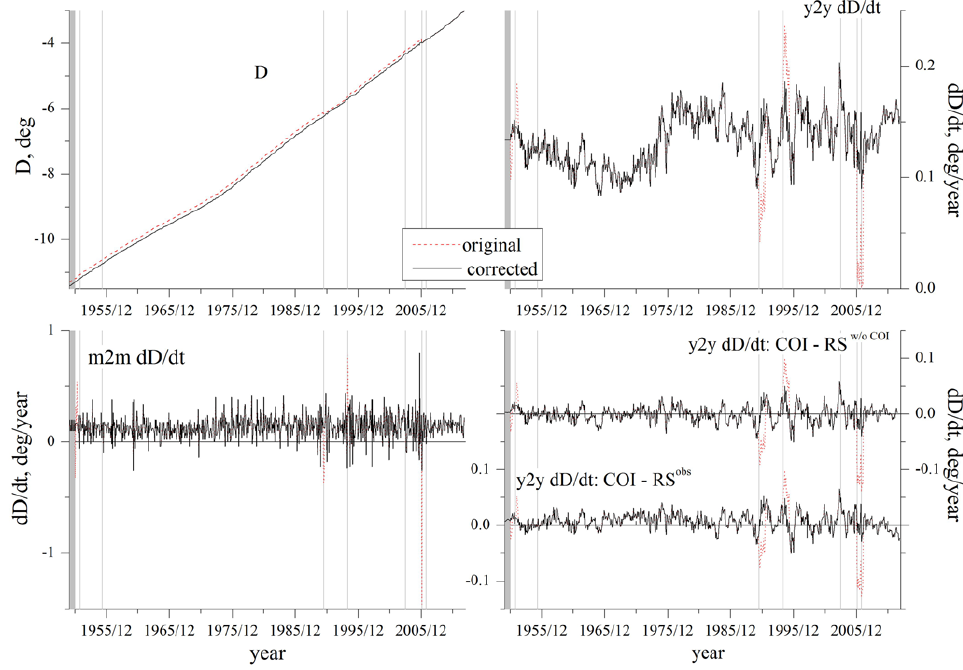
Fig. 12. Original (red dashed lines) and corrected (black solid lines) series of D (top left panel), first derivatives (m2m d D/ d t – bottom left panel; y2y d D/ d t – top right panel) and differences between first derivatives of COI series and reference series (bottom right panel) from 1951 to 2012. Breaks (see Table 3) are marked by vertical